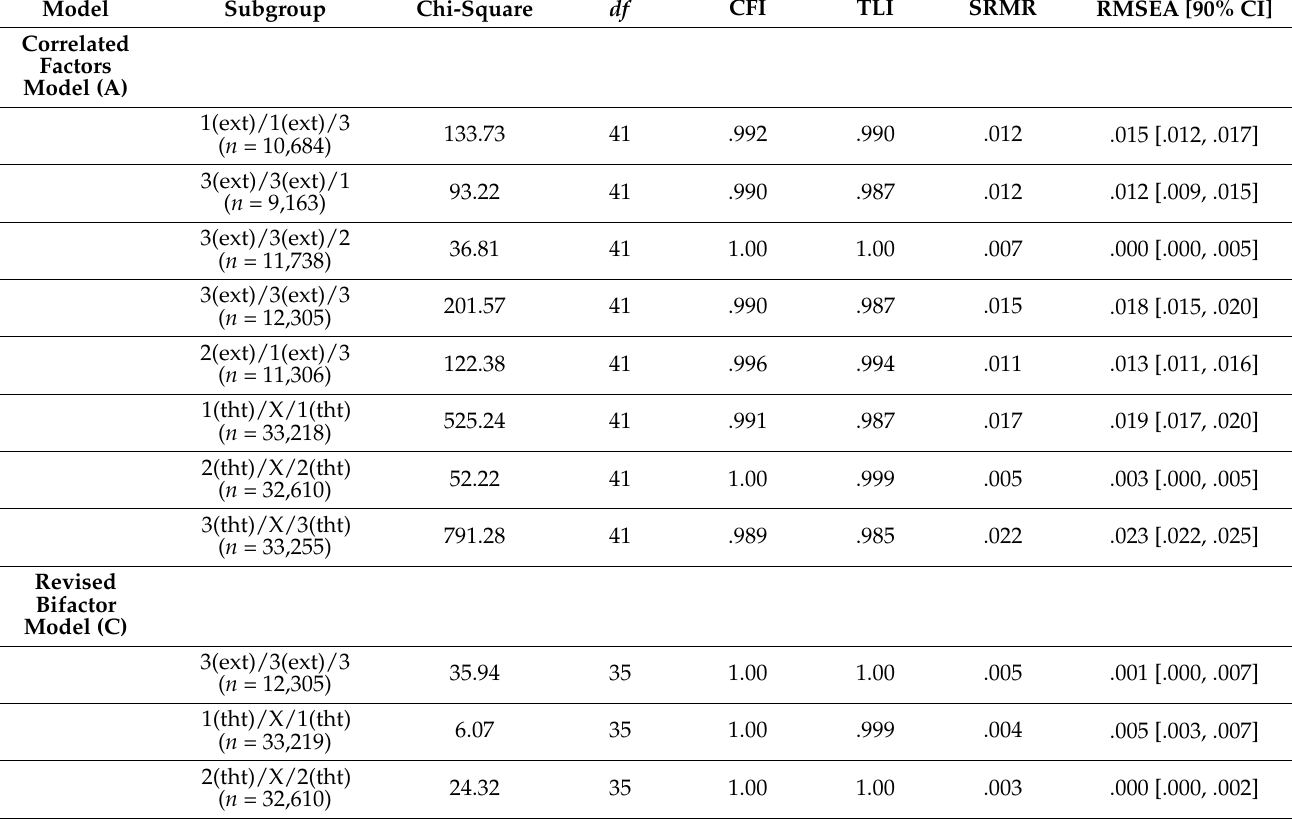
Table 3. Fit Statistics for Subgroups That Fit At Least One Model